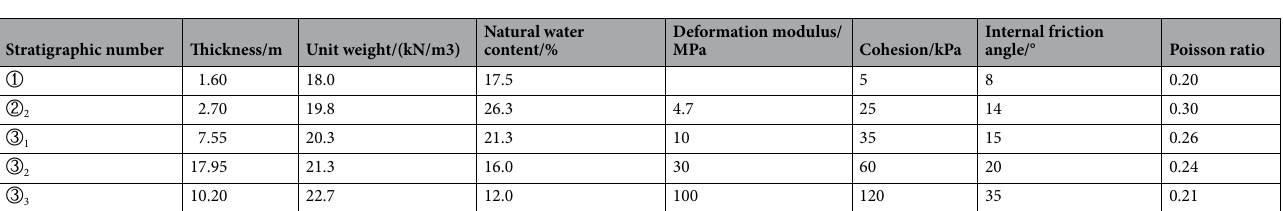
Table 1. Physical and mechanical parameters of different strata. Remarks: ① miscellaneous fill, ② 2 silty clay,